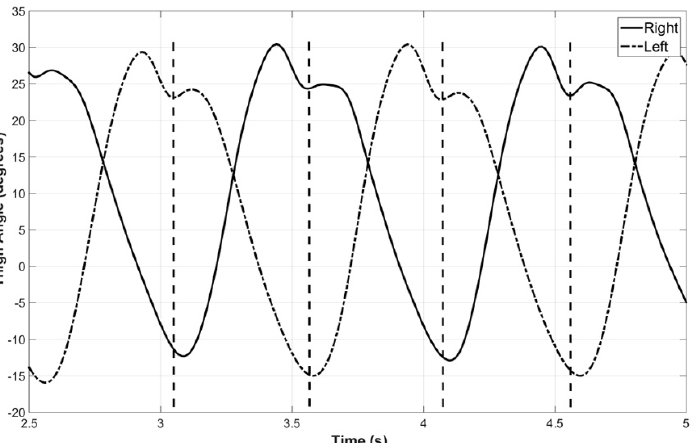
Figure 2. Thigh angles of left and right legs. This indicates that the toe-off of one leg is synchronized with the initial contact of the other leg, as shown by vertical dashed lines [15].